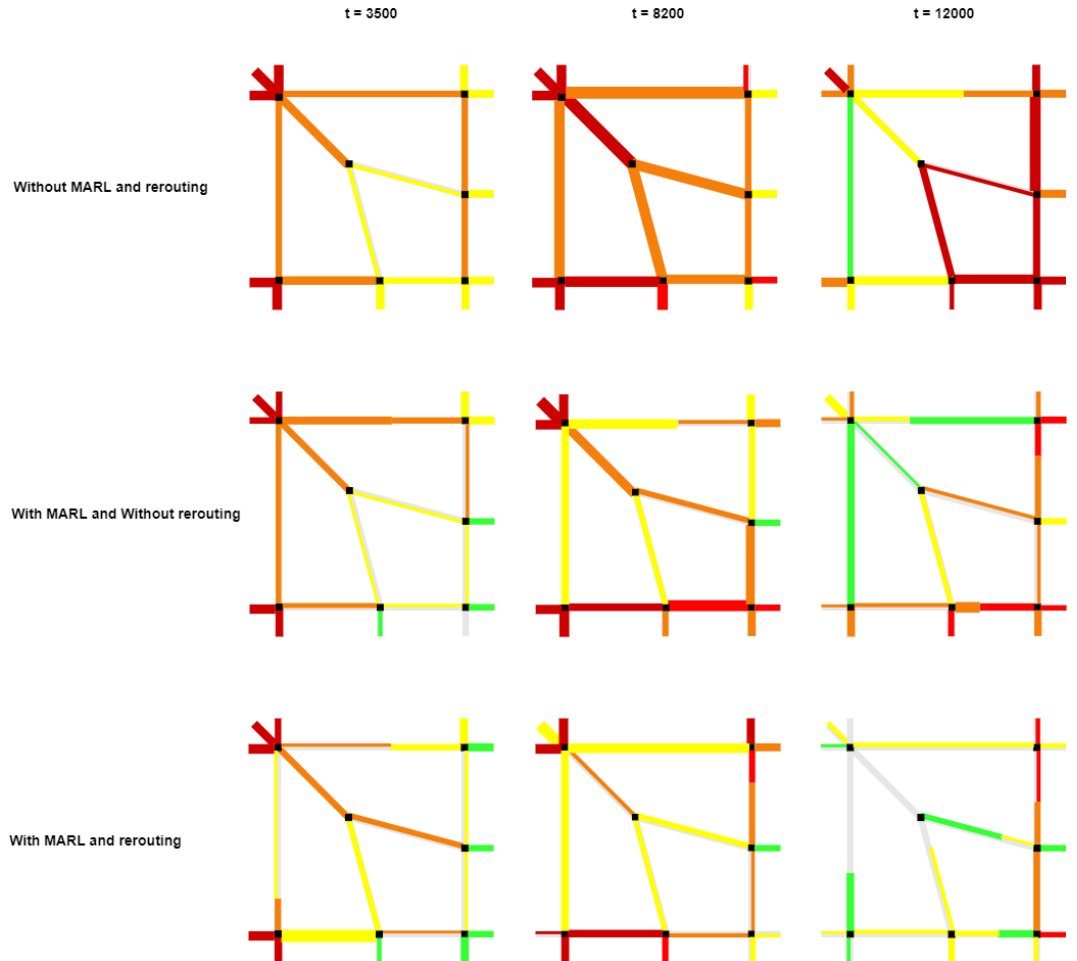
Figure 8. Congestion Model for improved traffic flow by our proposed